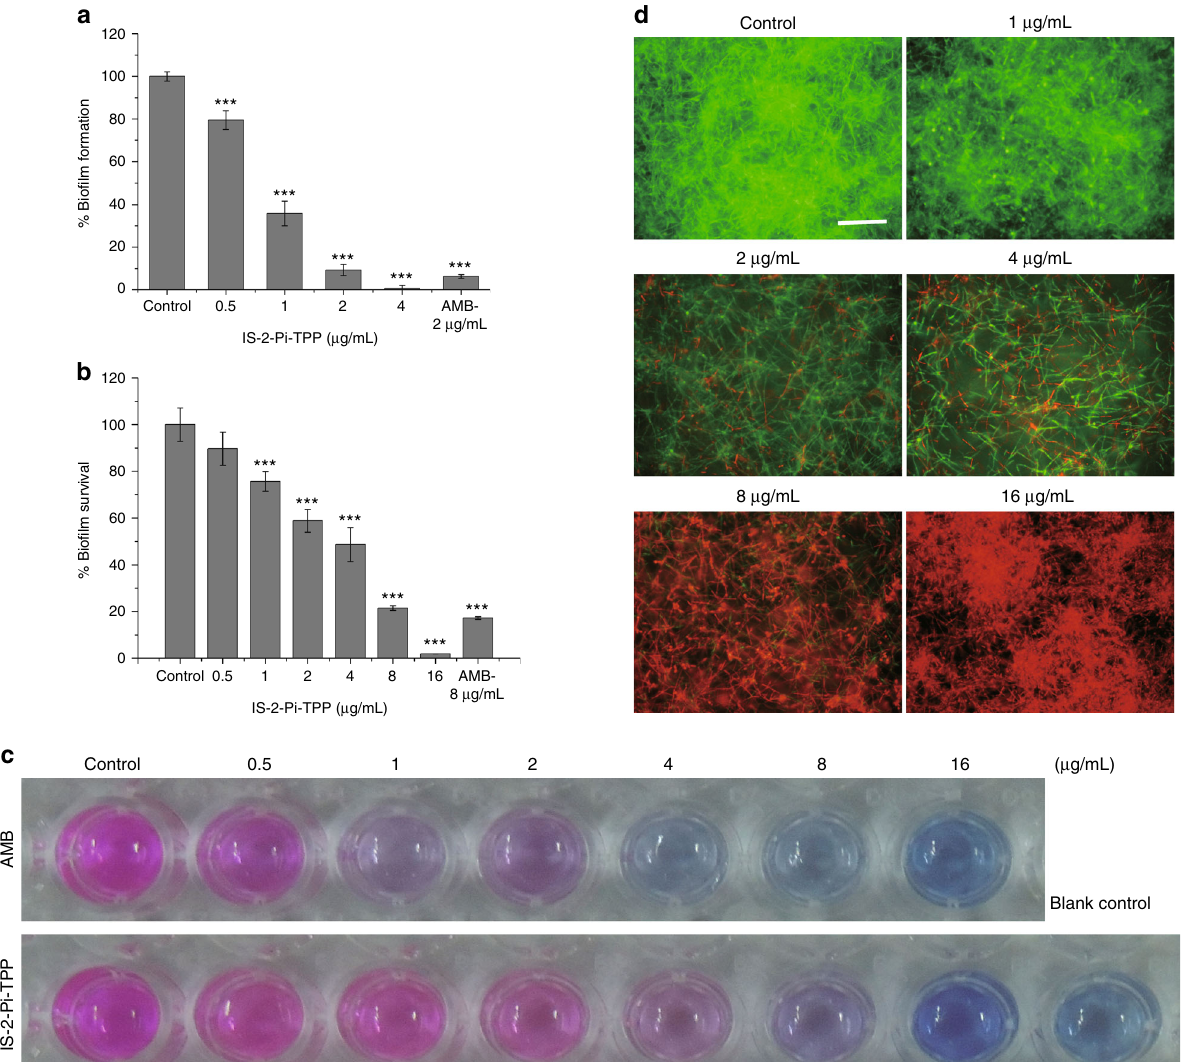
Fig. 4 The anti-bio fi lm activity of IS-2-Pi-TPP. a The inhibitory effect of IS-2-Pi-TPP on the formation of C. albicans bio fi lms. b , c The ability of IS-2-Pi-TPP to eradicate preformed C. albicans SC5314 bio fi lms was tested using the Alamar Blue assay. AMB served as a positive control. d IS-2-Pi-TPP-treated C. albicans SC5314 bio fi lms were stained by FDA and PI and subjected to microscopic observation. Scale bar, 100 μ m. Data are representative of three independent experiments. In a and b , data are shown as means ± s.e.m. Student ’ s t -test was performed. *** P < 0.001 versus the